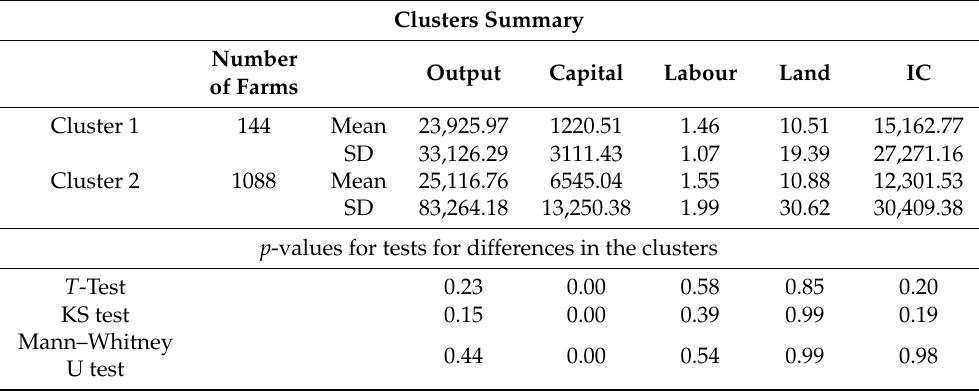
Table 4. Clusters summary and separation.